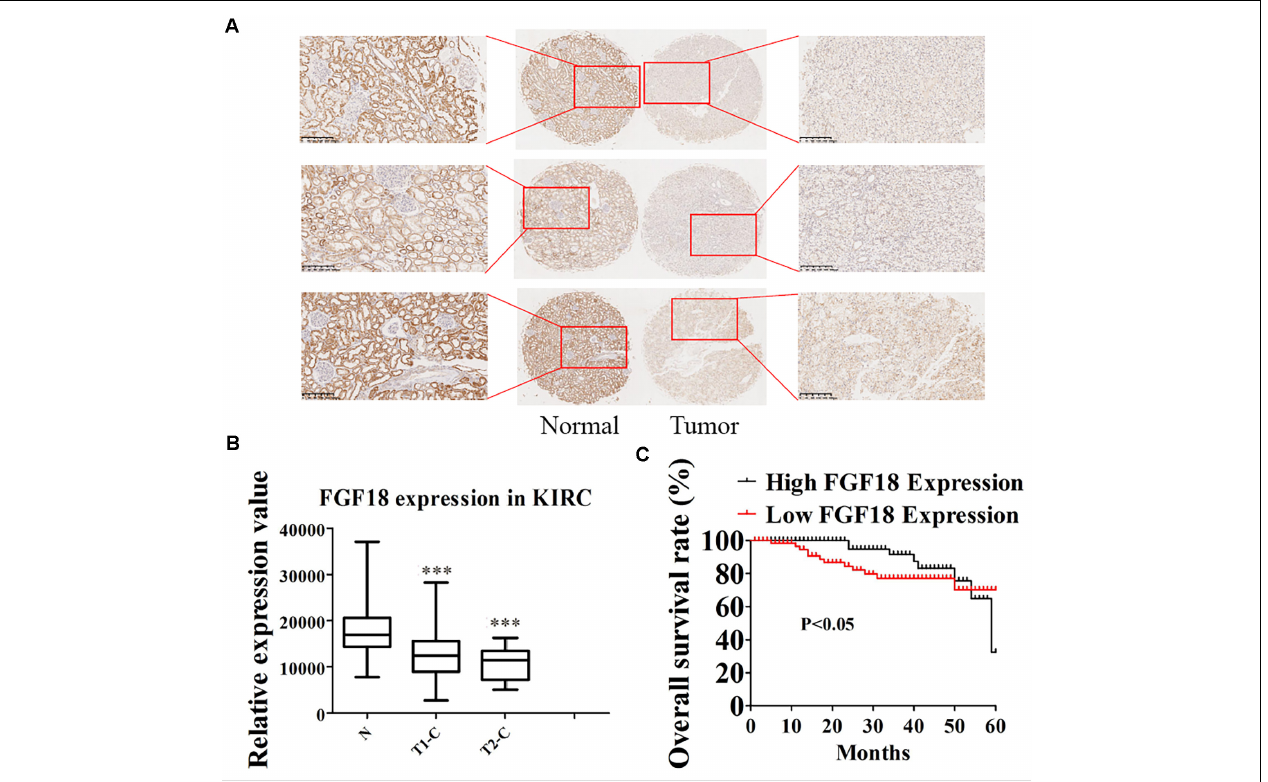
FIGURE 2 | Low expression of FGF18 in ccRCC correlates with better patient prognosis. (A) The expression of FGF18 in ccRCC was analyzed using IHC on a ccRCC tissue microarray (82 cases). (B) Analysis of relatively FGF18 expression in ccRCC normal tissue, cancer tissue of T1 stage, and cancer tissue of the T2 stage. ∗∗∗ p < 0.001 versus the normal group. (C) The prognostic significance of FGF18 expression for ccRCC patients was determined with IHC values, using the median value as the cutoff. The observation time was 60 months.